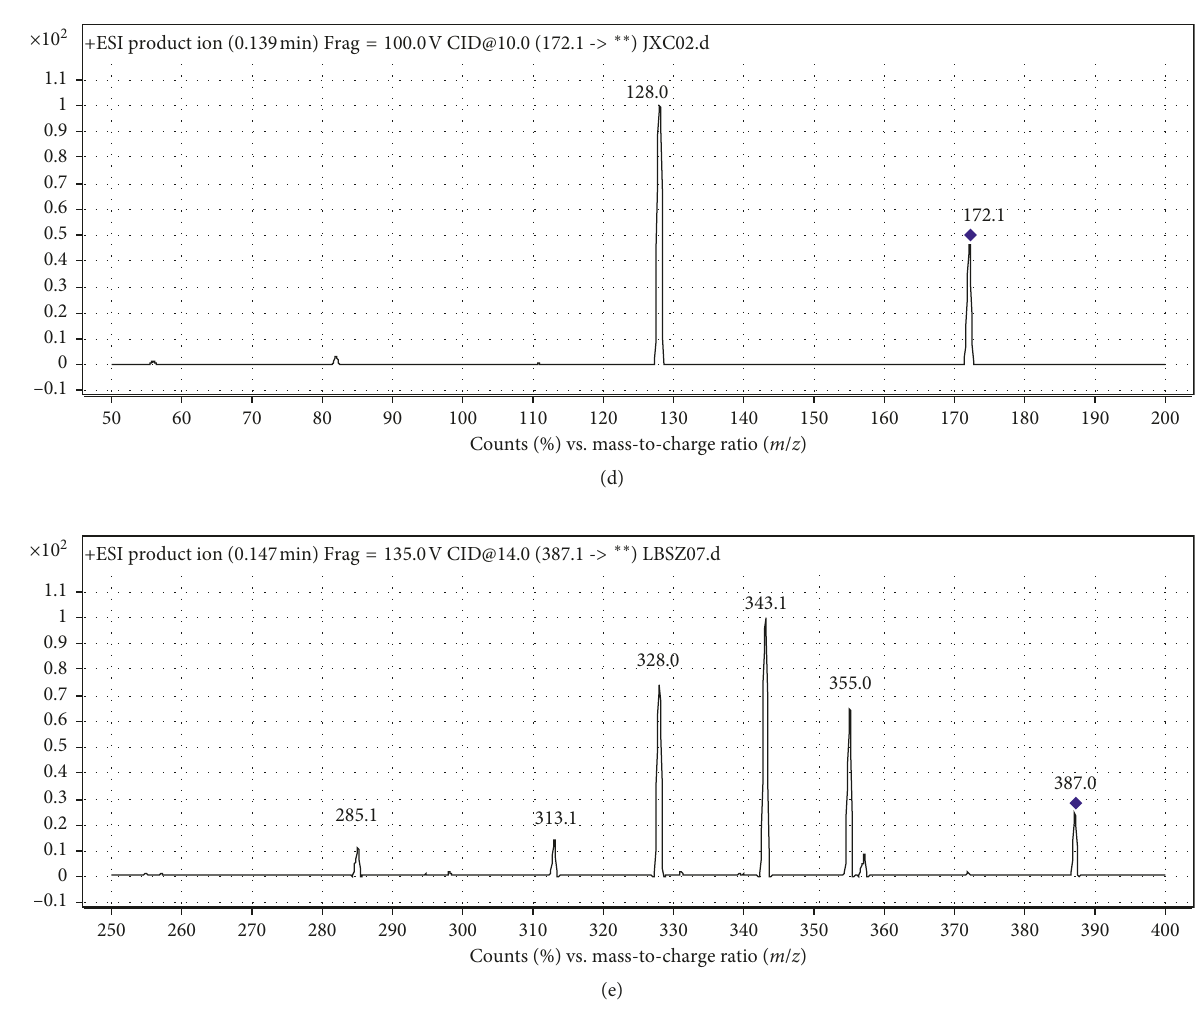
Figure 2: MS scans for (a) promethazine hydrochloride, (b) PMZSO, (c) schisandrin, (d) metronidazole, and (e) Table 1. The monitored precursor-product ions in the MRM mode provided high selectivity and sensitivity for quanti- fication. Key parameters, such as fragmentor and collision energy, are also optimized in Table 1.